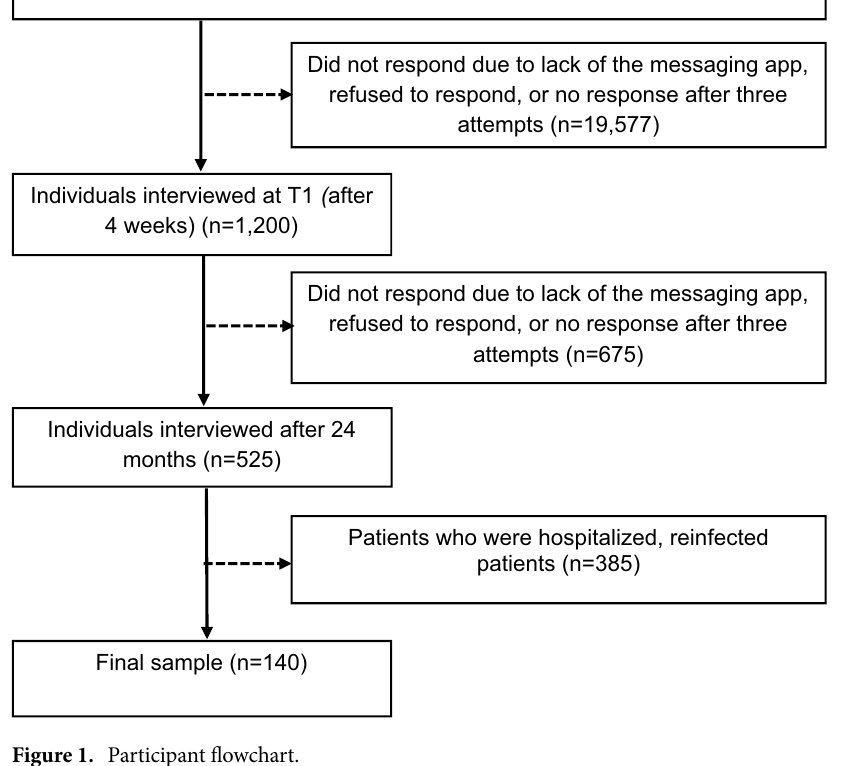
Figure 1. Participant